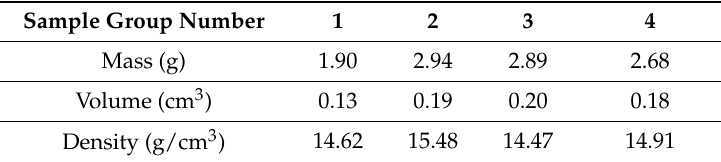
Table 3. Density of WC–Co cemented carbide.